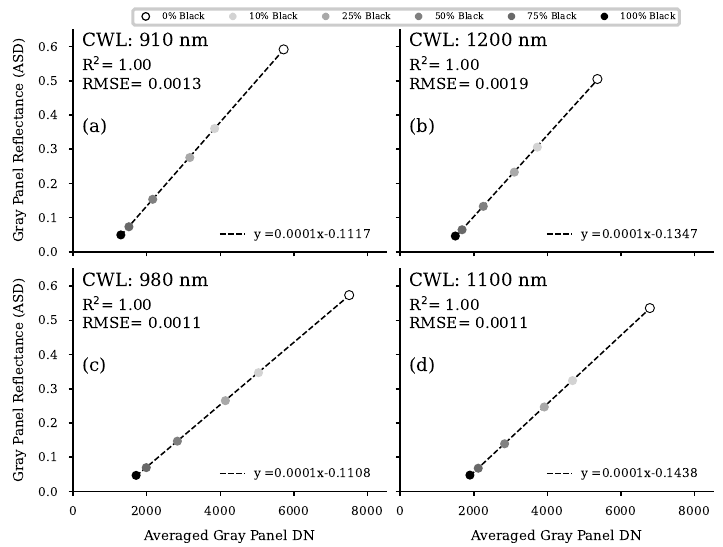
Figure A2. Regression analyses of the grayscale panel DN values measured in the flat-field corrected image data and the reflectance of the gray panels, measured by a portable ASD FieldSpec3 spec- troradiometer (Malvern Panalytical Ltd, Malvern, United Kingdom) (ASD). For each of the four wavelength bands ( a – d ), five images were analyzed, and the resulting DNs of the respective gray panels were averaged. ( p < 0.001 for all regression models).